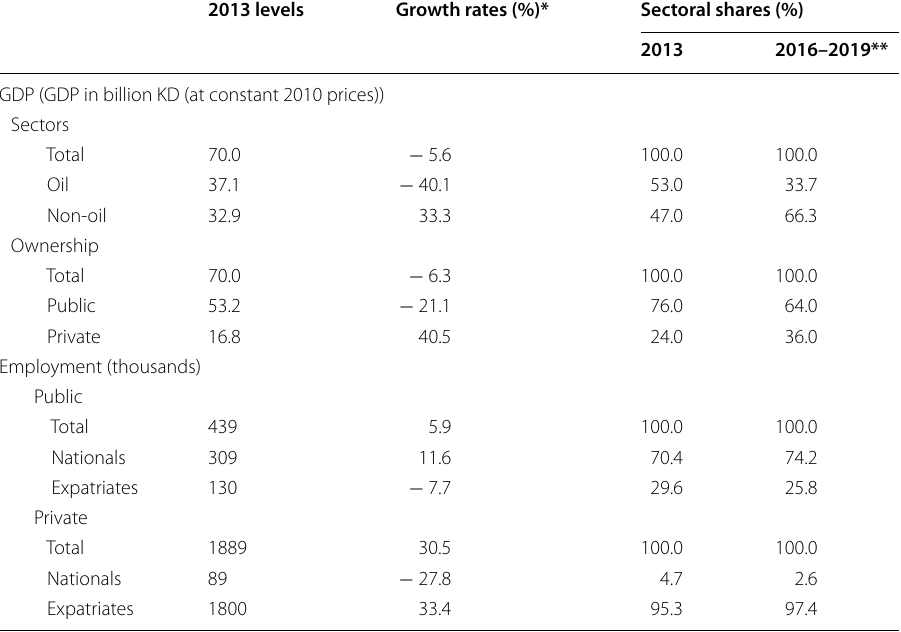
Table 1 Changes in the composition of the Kuwaiti economy (2013–2018). Sources: GDP based on CSB (2017), Employment based on PACI (2020) (annual data archived from this source for various